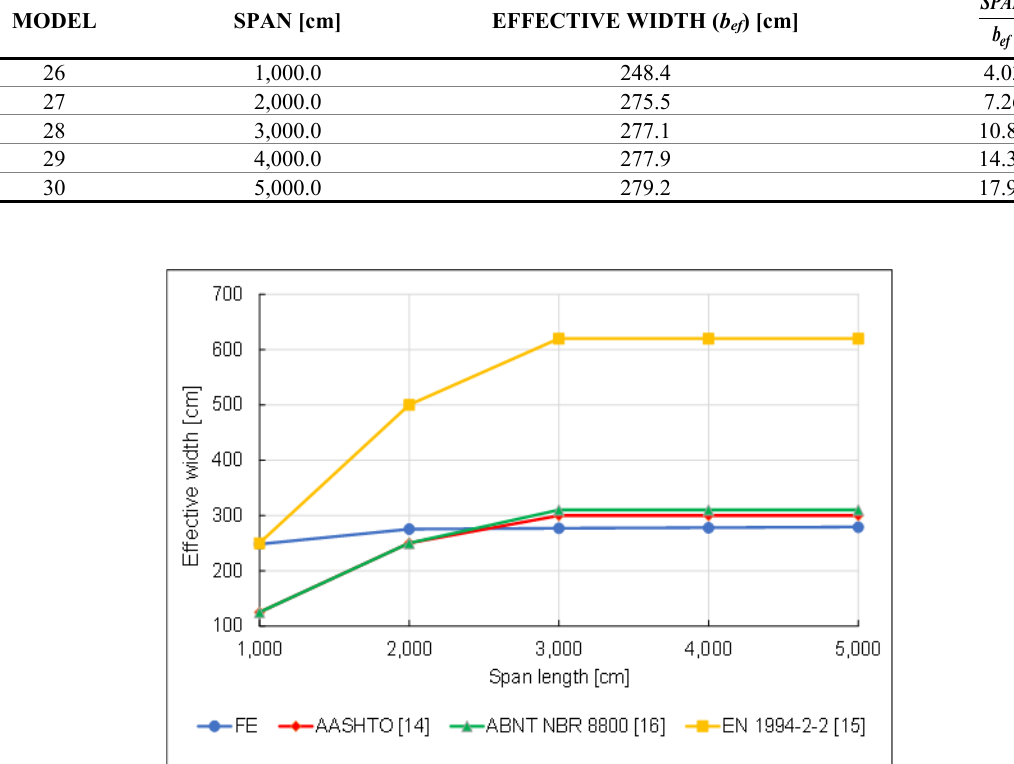
Table 8. Relationship between the effective numerical width and the longitudinal span length for the double box con figuration. MODEL